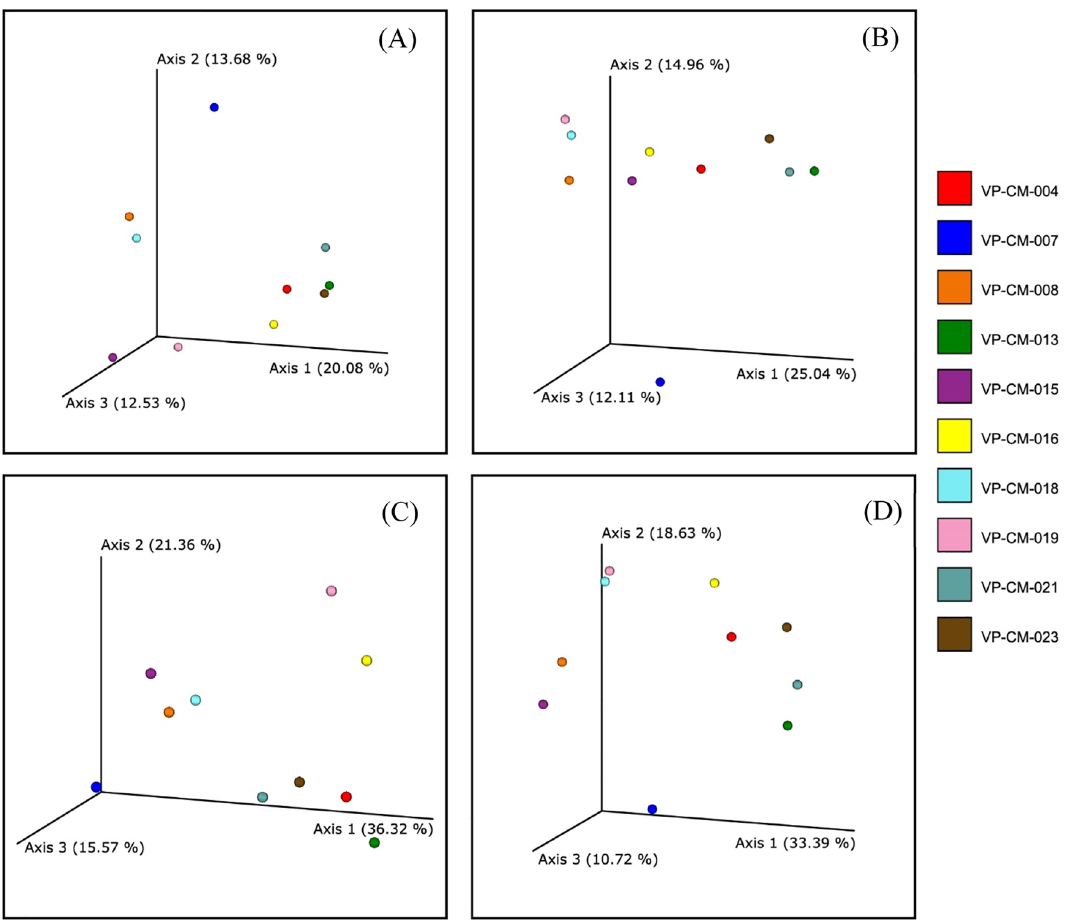
Figure 2. Principal coordinate analysis (PCoA) of the ( A ) Bray–Curtis dissimilarity, ( B ) Jaccard distance matrix, ( C ) weight Unifrac, and ( D ) unweight Unifrac to illustrate the beta-diversity analysis of bacterial communities between ten different lichen